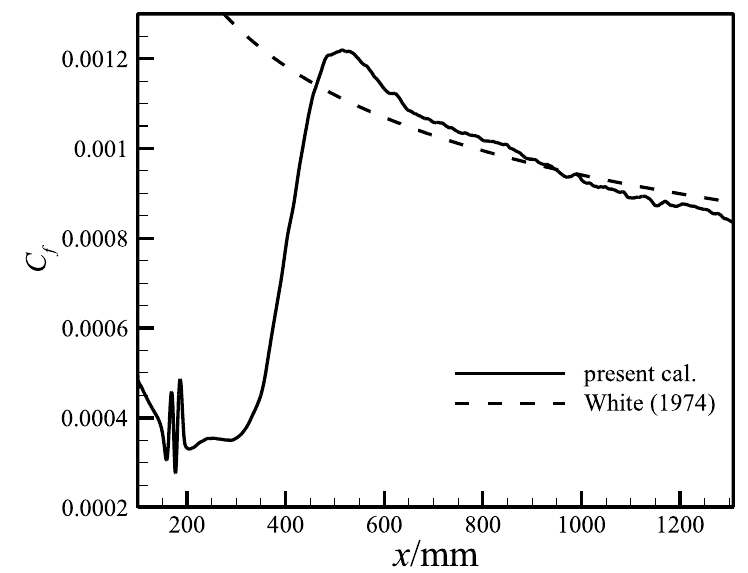
Fig. 3 Skin friction coefficient along the streamwise direction and White law